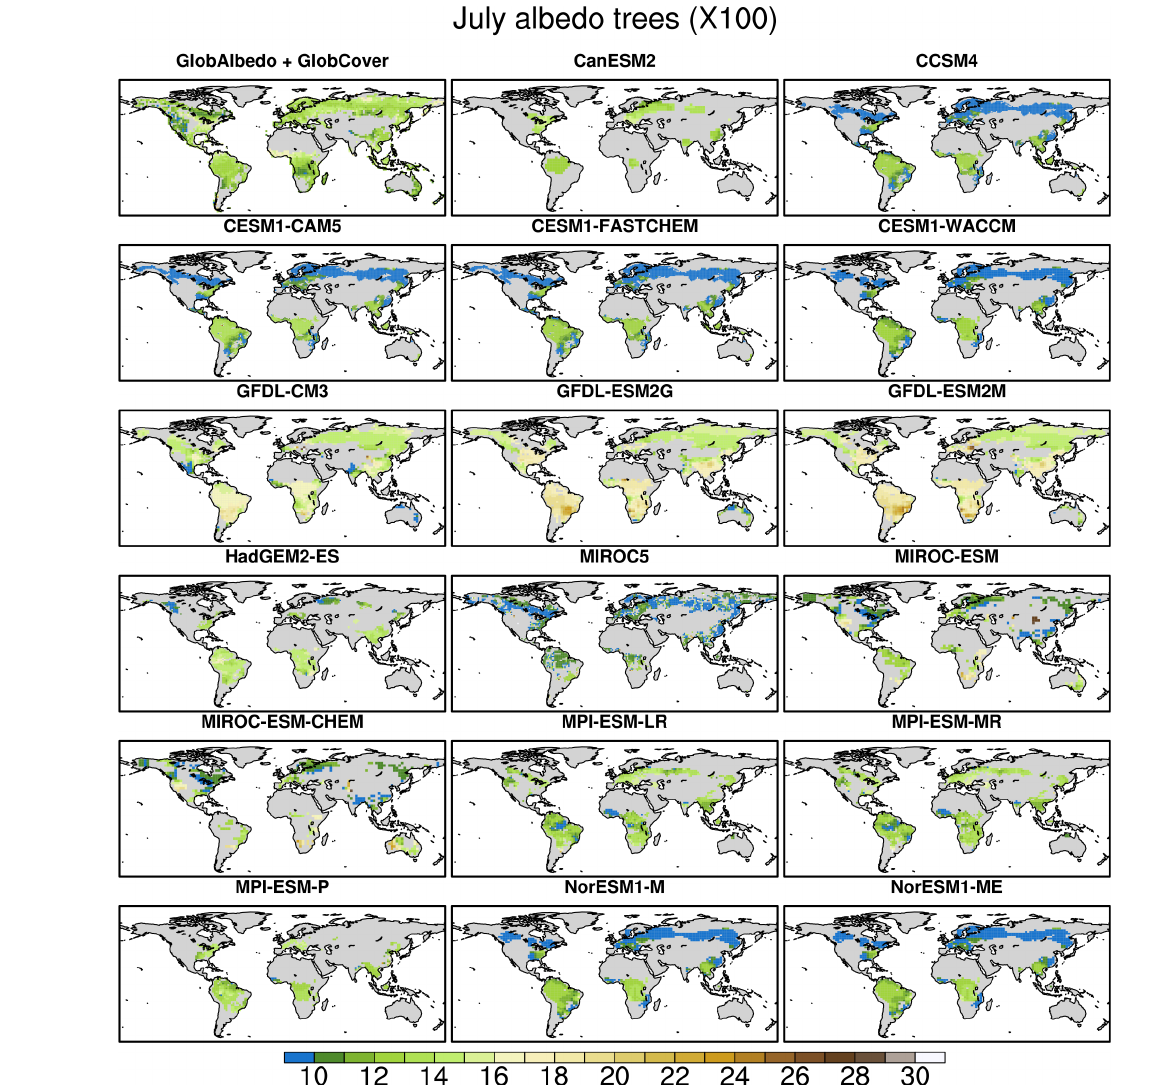
Figure 6. Present-day July albedo of trees retrieved from the combination of observational data from GlobAlbedo (over the 1998–2011 pe- riod) and GlobCover (2005–2006, top left corner), as well as in the analysed CMIP5 models (the climatology over the 2000–2004 period was considered). Note that the albedo values have been multiplied by 100 to facilitate